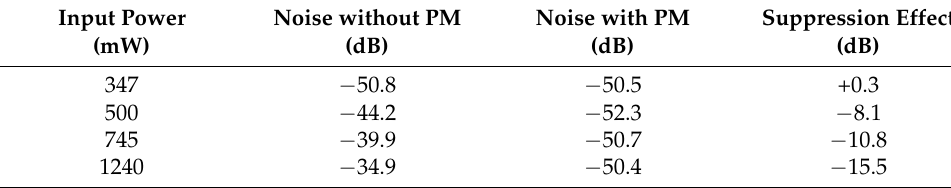
Table 1. The phase noise suppression effects at 20 km